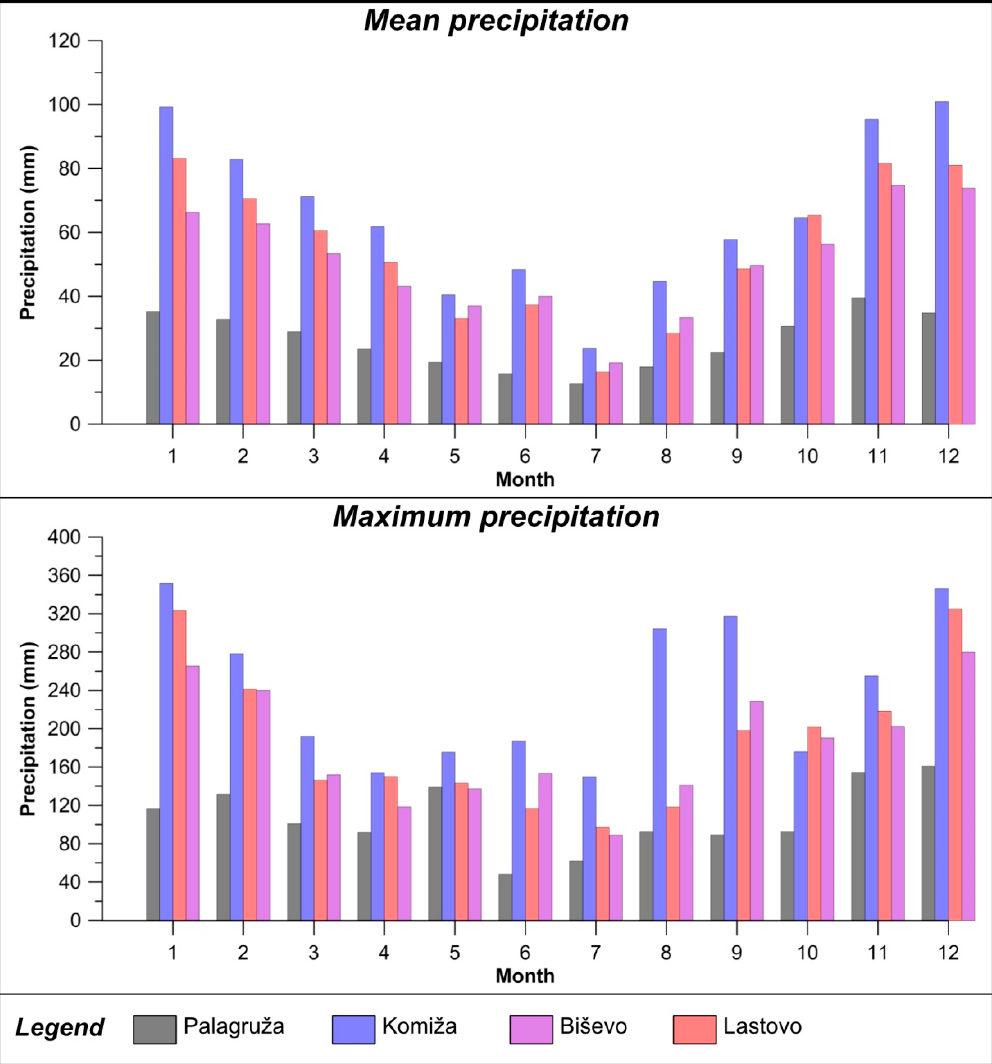
Figure 8. Histograms of the mean and maximum values of the monthly precipitation at the analyzed stations.